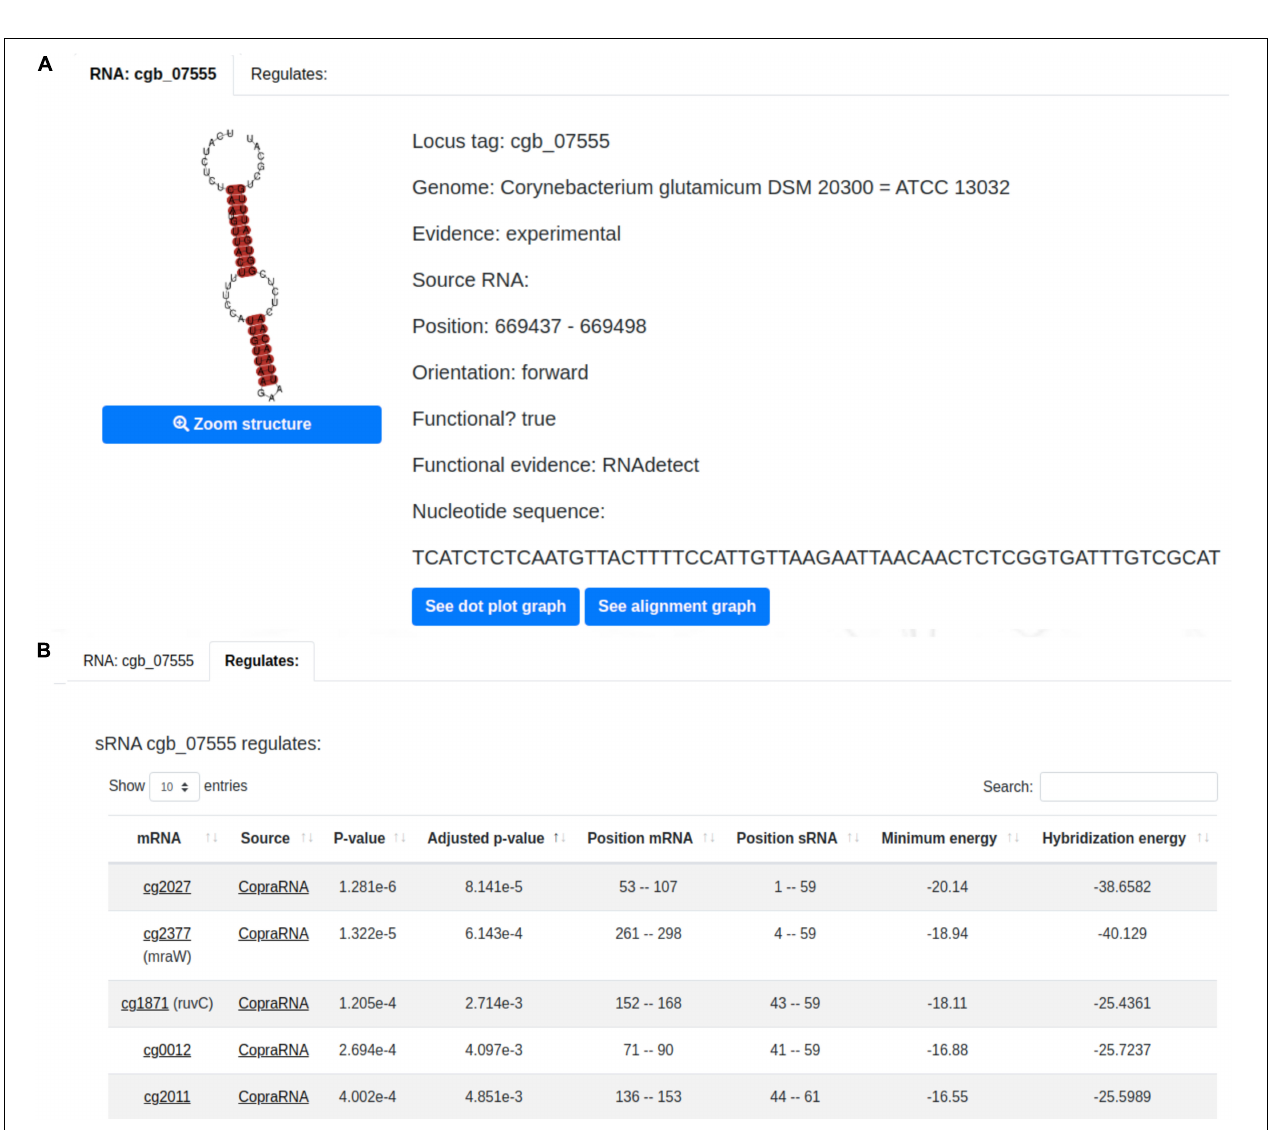
FIGURE 3 | CoryneRegNet 7.5’s sRNA details page with (A) essential information of the sRNA cgb_07555 and (B) its regulations.